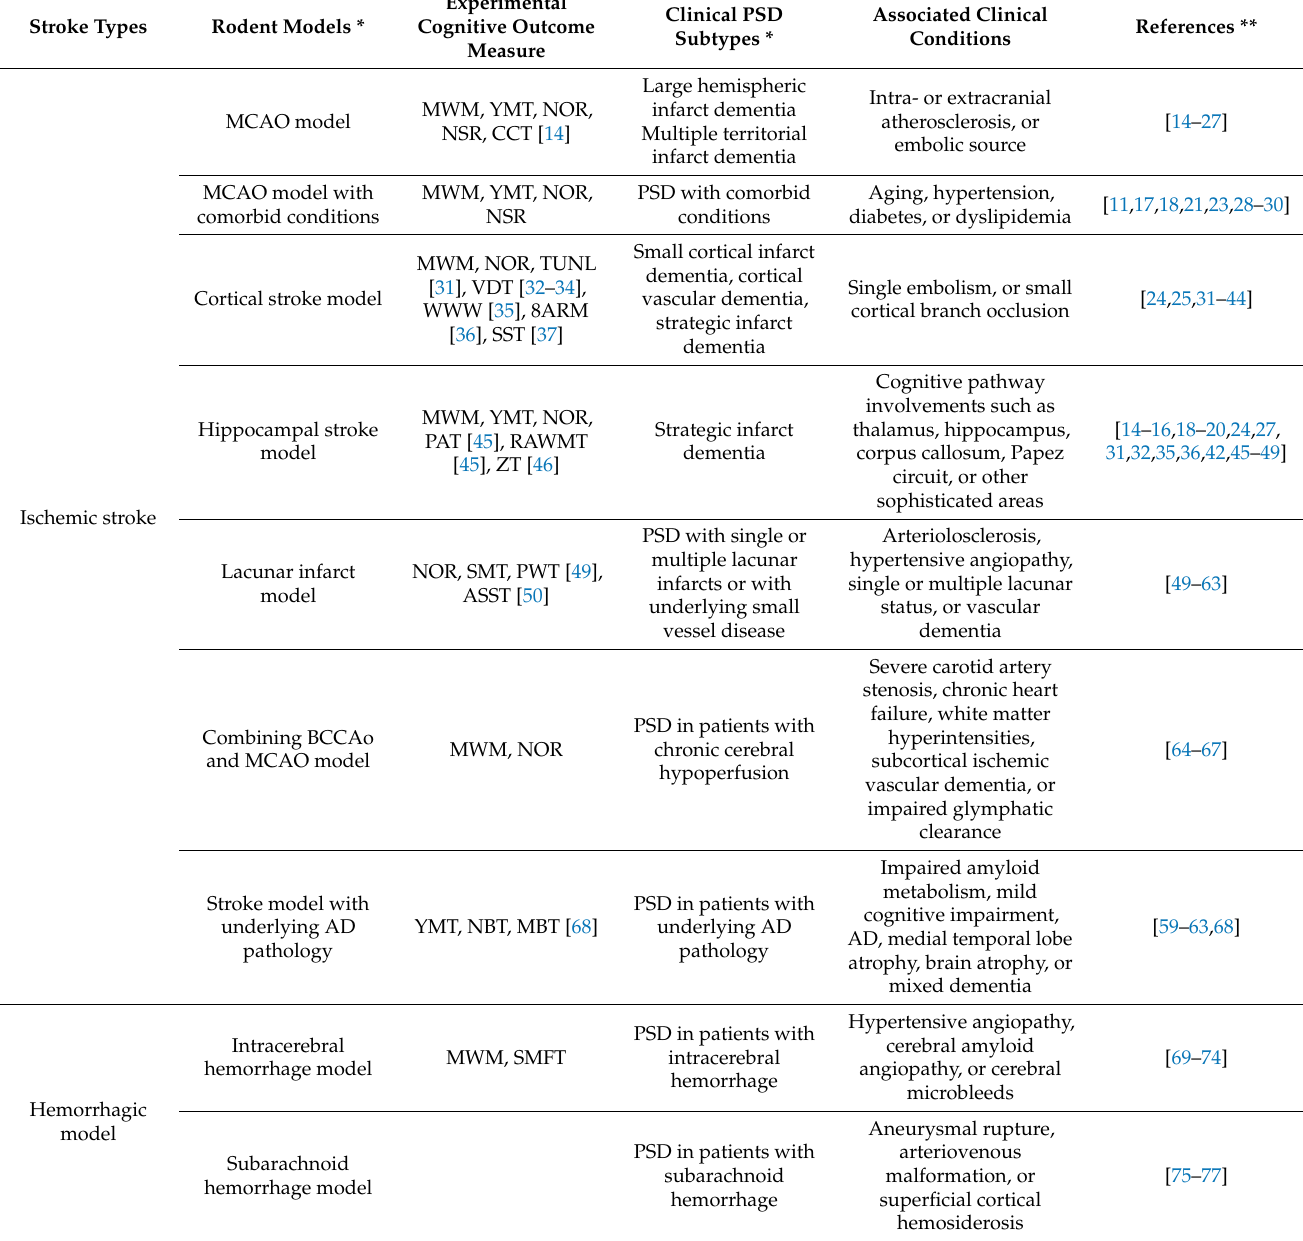
Table 1. Rodent animal models of post-stroke dementia (PSD) vs. comparative clinical PSD subtypes and its associated clinical